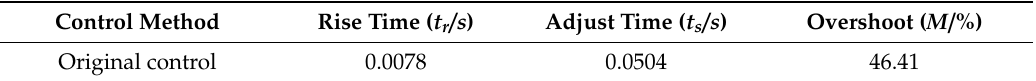
Figure 4. Original control Simulink simulation results. Table 2. Simulation results of original control.